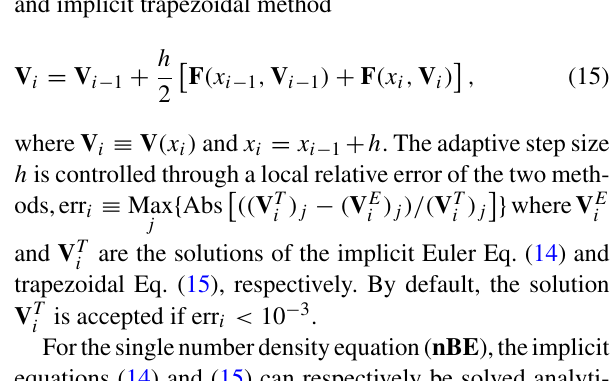
Fig. 1 Flowchart showing DRAKE ’s main routines as called by the main.wls template script. The three user specified input < files > in the green boxes should contain the DM model definition, numerical values on model parameters and option settings for DRAKE (see main text and Appendix A). The command GetModel then loads the content from these < files > before the script continues to execute the required preparatory routines. The preparatory routines PrepANNtheta and PrepSCATT will not be called if the options Analyticsvtheta or FullCell are set to True , respectively; in that case the quantities